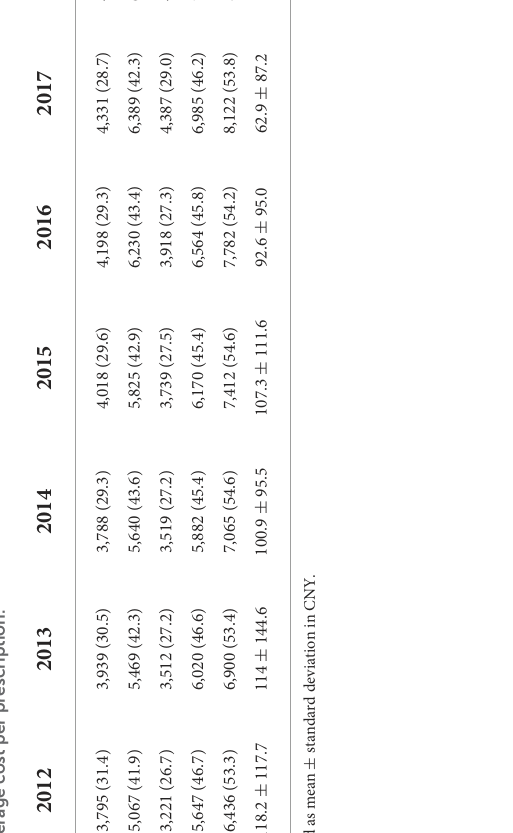
their prescriptions increased progressively during the 10 years (both P < 0.001), while prescriptions that contained acyclovir decreased over the study period ( P = 0.002). The percentages of prescriptions that contained valaciclovir and famciclovir in individual hospitals were calculated, and their yearly distributions are shown in Figure 2. Our findings indicate that the treatment patterns differed greatly among hospitals. Some hospitals prescribe valaciclovir to most patients, while others prescribe valacyclovir to a very small percentage of patients. Ganciclovir was rarely used, and its prescription was stable ( P = 0.530). There were also two topical formulations, acyclovir and penciclovir, both of which showed increasing trends in prescription numbers over the study period ( P = 0.020 and P = 0.002,